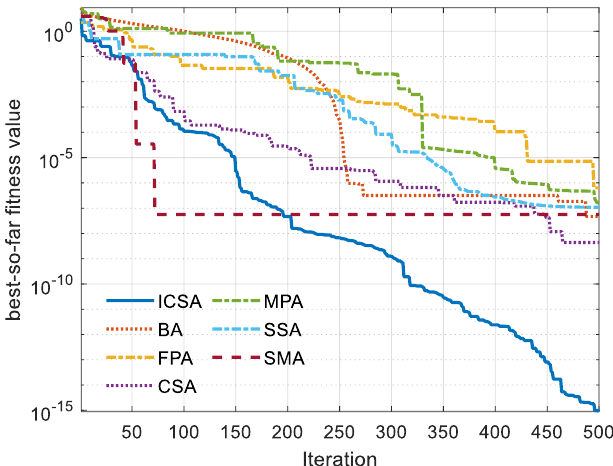
Figure 13. Convergence curve for F13.